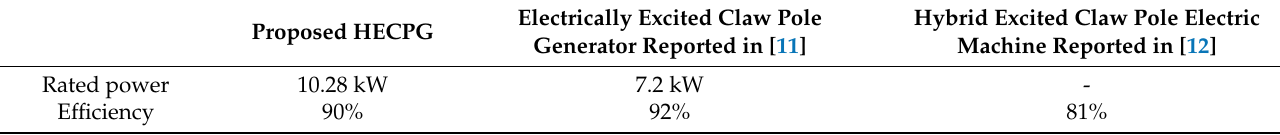
Table 4. Performance